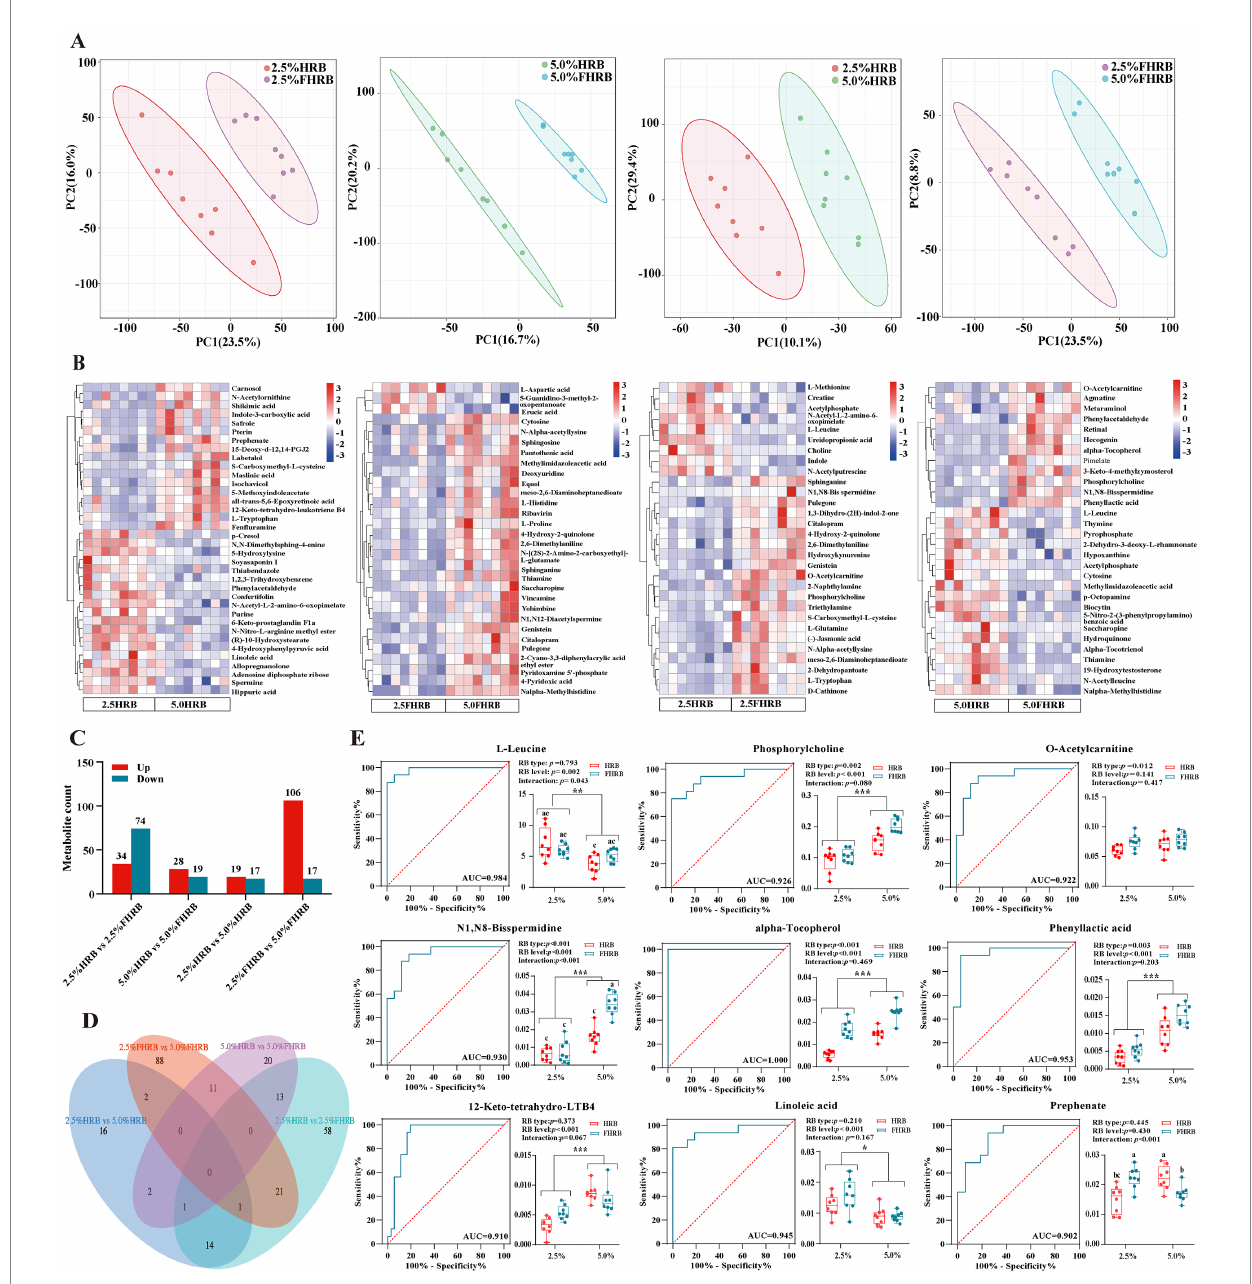
FIGURE 3 Effects of RB type and feeding level on the cecal metabolic profiles of laying hens. (A) Partial least squares projection to latent structures and discriminant analysis (PLS-DA) based on the LC-MS metabolite profiles of the cecal compound data. (B) Differential metabolite clustering heatmap of cecal chyme in the two groups (top 30). (C) Statistics of differentially expressed metabolites. (D) Venn diagram of differential metabolites between different groups. (E) ROC analysis of nine different biomarker metabolites based on AUC values ≥ 90% as potential biomarkers for the effects of RB type and feeding levels in laying hens. * and * * indicate significant ( P < 0.05) and highly significant ( P < 0.01) differences at feeding level, respectively. Based on interaction p < 0.05, a–c values with different letters are significantly different at p < 0.05.